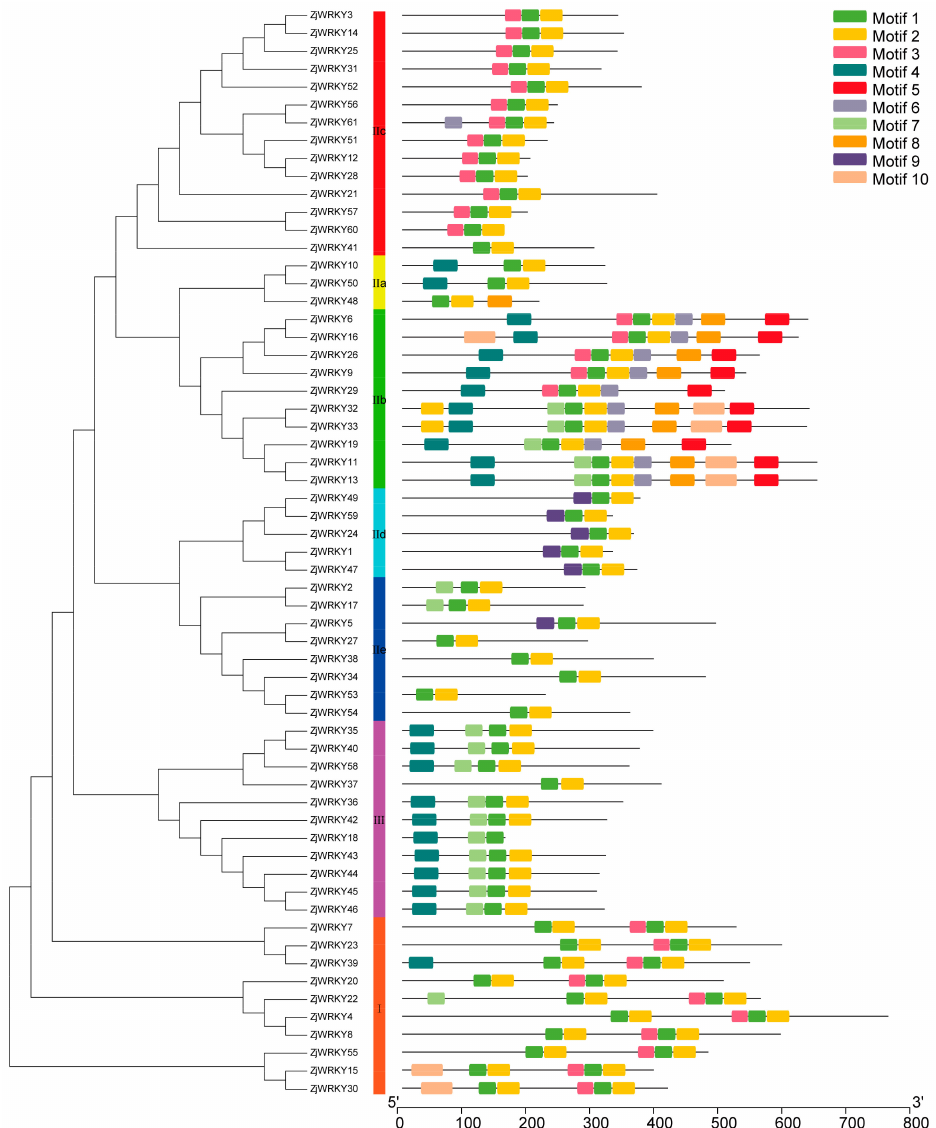
Figure 3. Phylogenetic tree and motif composition of ‘Junzao’ WRKY proteins. The phylogenetic tree was constructed using MEGA7.0 with the neighbor-joining method and 1000 bootstrap replicates (substitution model: Jones–Taylor–Thornton model). Multiple Em for Motif Elicitation (MEME) was used to predict motifs. Ten motifs were identified and were represented by di ff erent colors. The position of the motif on the chromosome was